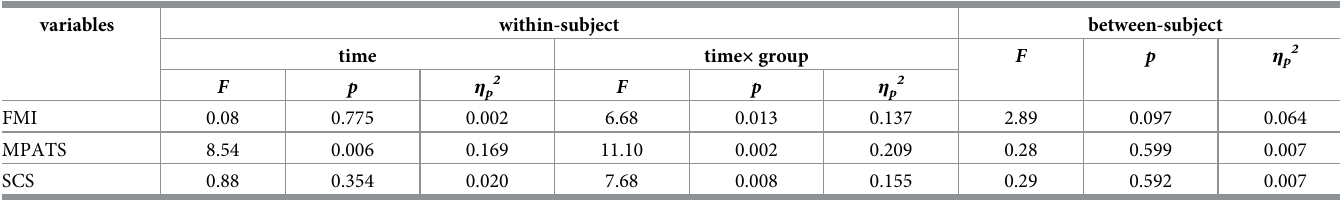
Table 3. Summaries of two-way repeated-measures ANOVA comparison.